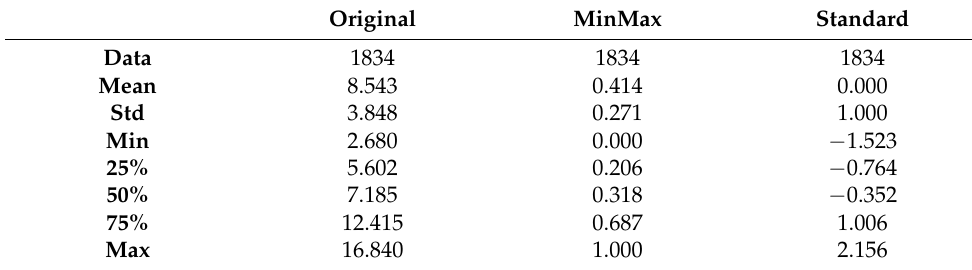
Table 2. Statistics of the reduced